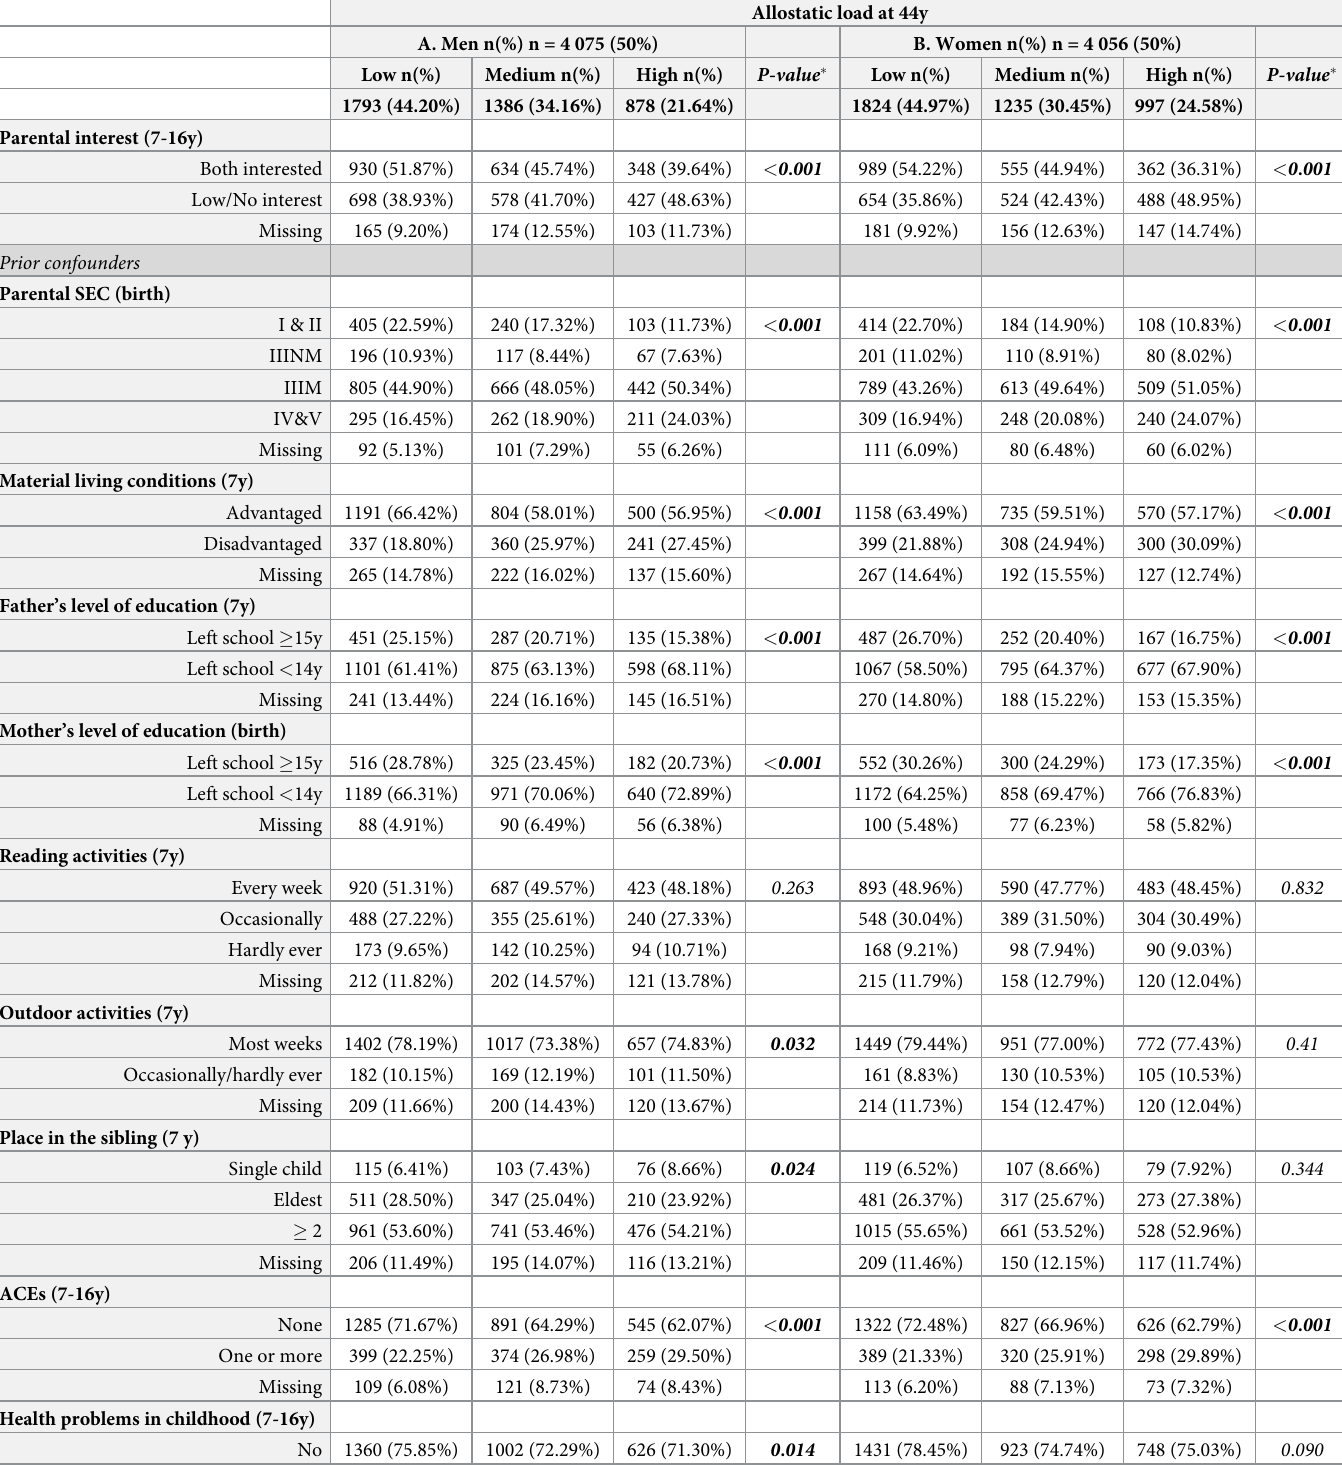
Table 1. Bivariate statistics on the complete-case sample (n = 8 113): Allostatic load categories according to confounding and intermediate variables in (A) men and in (B)